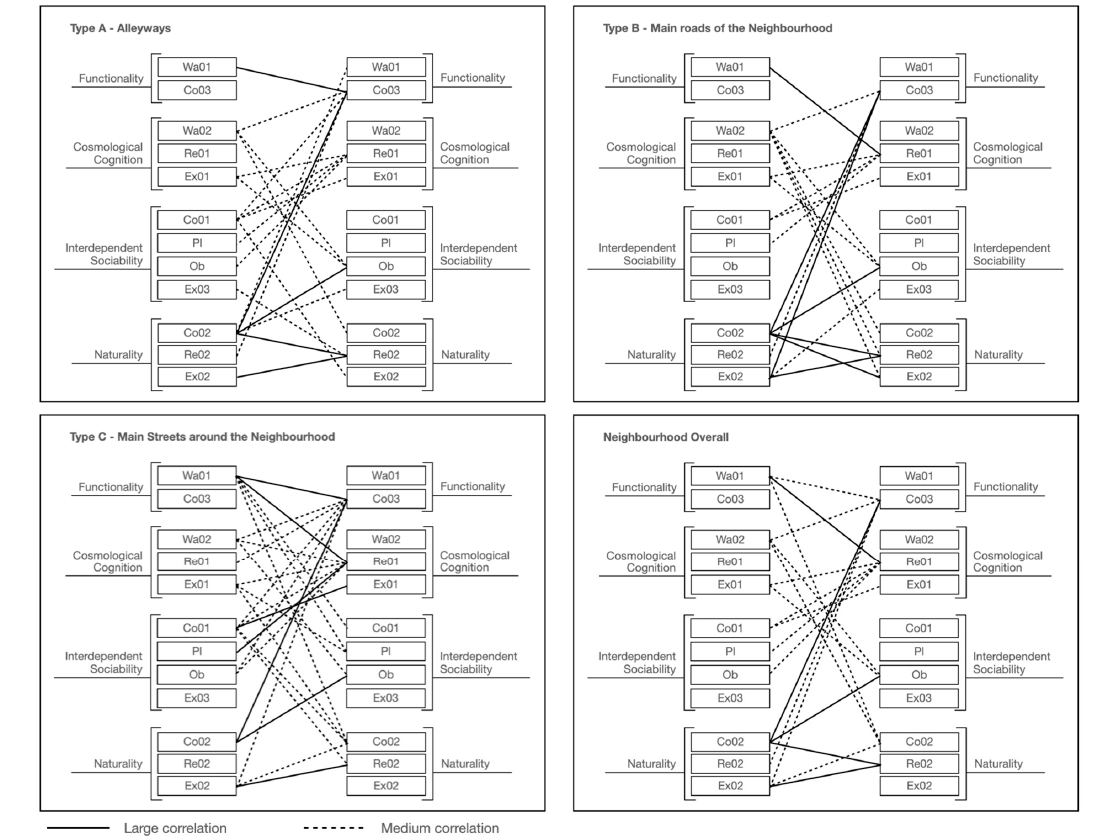
Figure 11. Medium and large correlations between indicators of local place qualities.